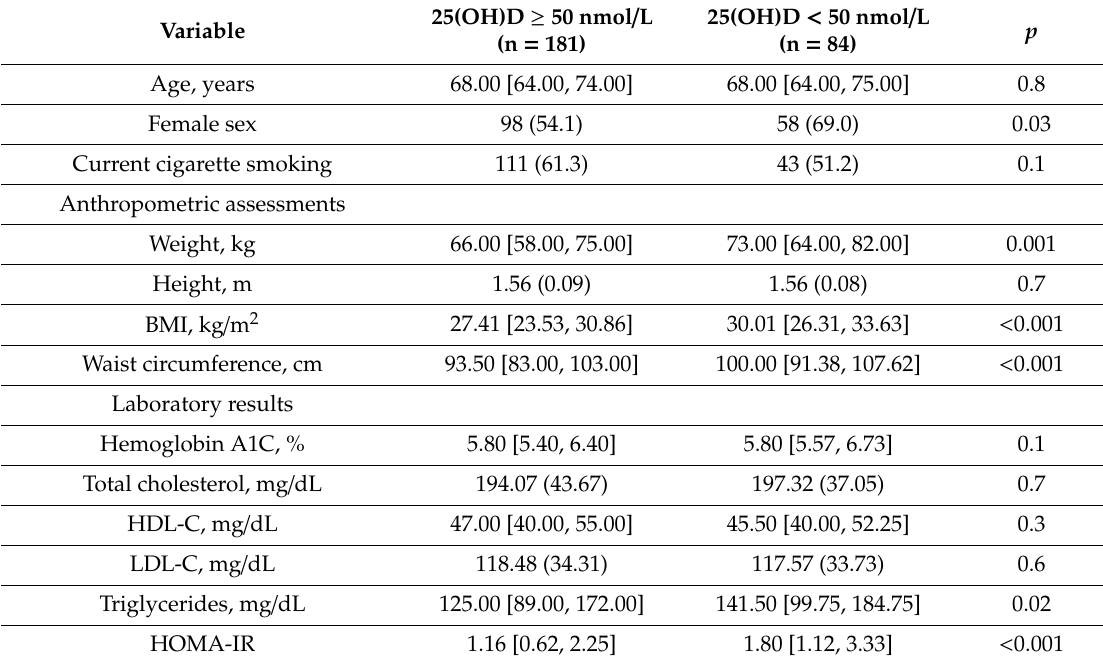
Table 1. Anthropometric parameters, inflammatory and metabolic profile in the population studied (n =